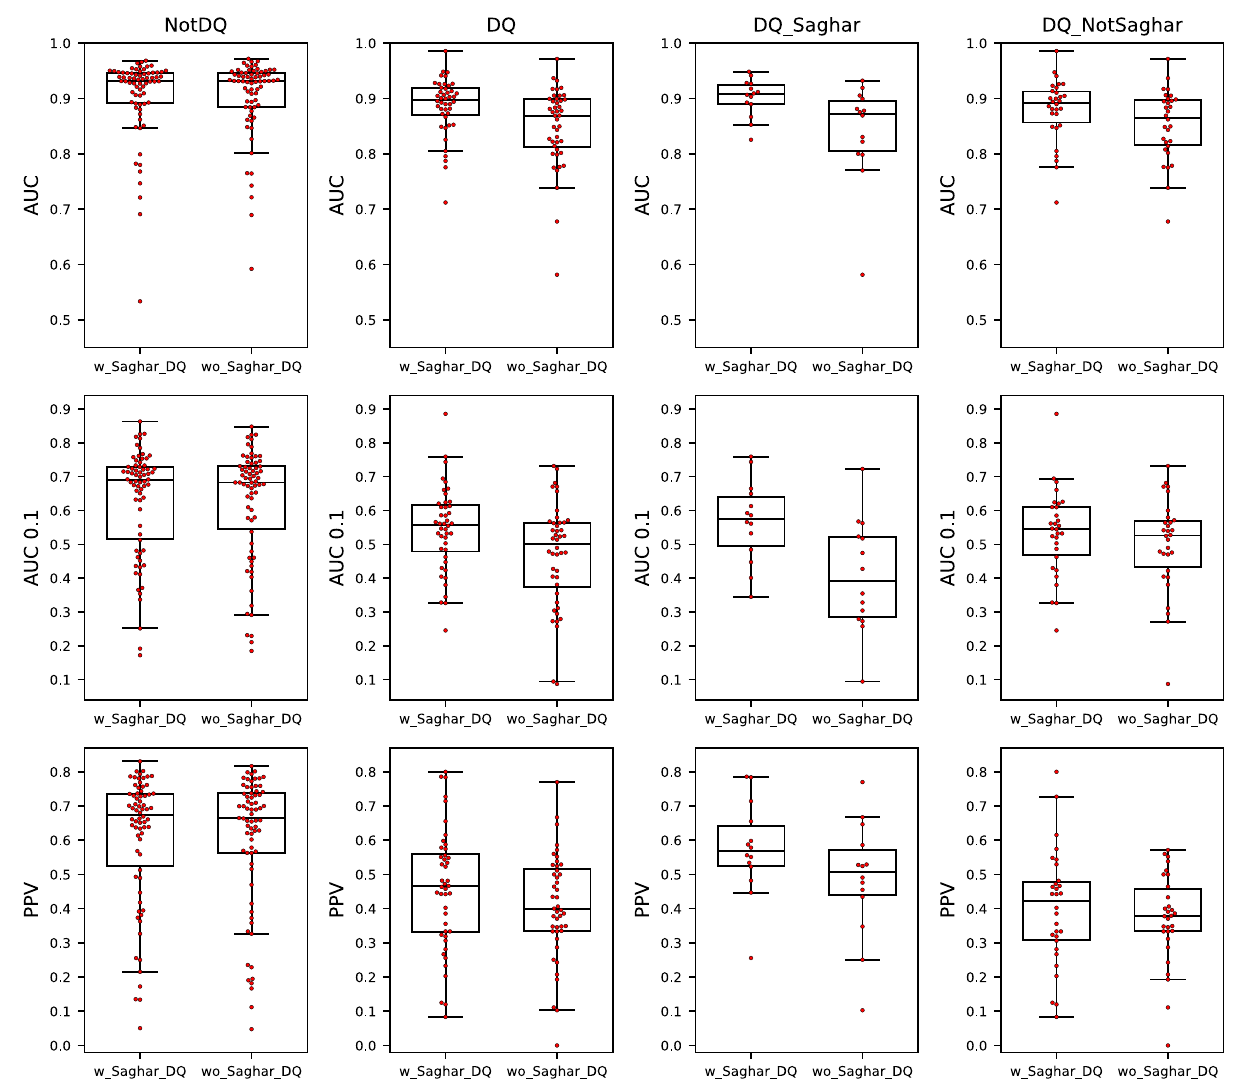
Fig. 2 AUC, AUC 0.1 and PPV predictive performance for the models trained with (w_Saghar_DQ) and without (wo_Saghar_DQ) the novel data. Each point is the performance metric for a unique HLA class II molecule. For details on the performance metrics refer to materials and methods. The columns correspond to four different subsets of HLA molecules, namely all non-HLA-DQ molecules (NotDQ, n = 70), all DQ molecules (DQ, n = 44), DQ molecules in the novel data set (DQ_Saghar, n = 14), and DQ molecules not present in the novel data (DQ_NotSaghar, n = 30). Each boxplot shows the median inside the interquartile range (IQR) between the upper and lower quartiles, with whiskers extending to at most 1.5 times the